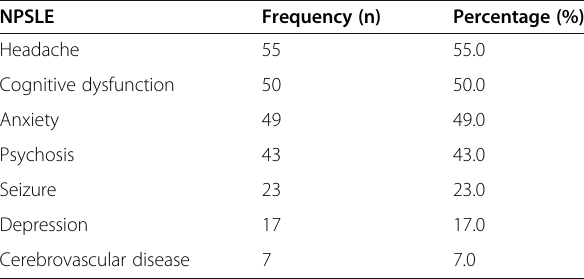
Table 2 Prevalence of observed NP manifestations among study population